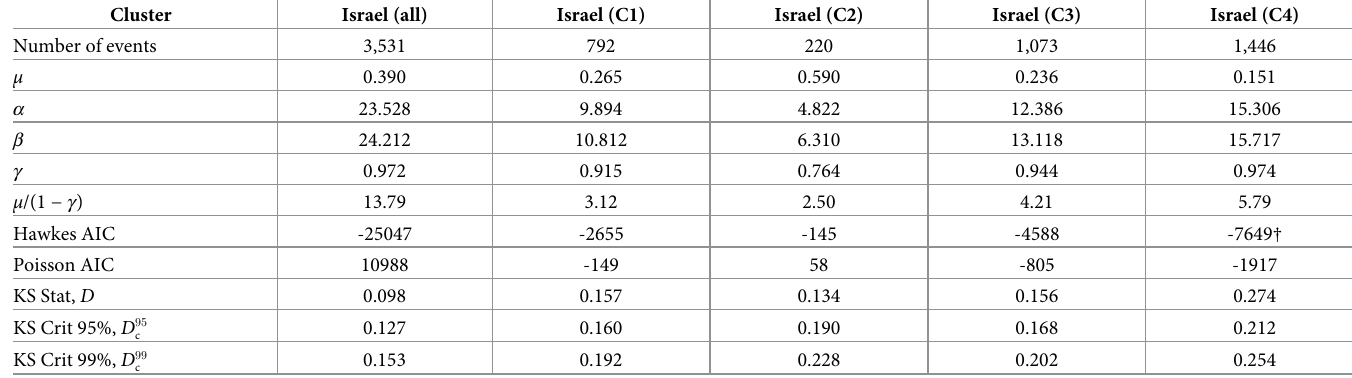
Table 3. Statistical outcomes of the Hawkes process applied to data from Israel. The Hawkes process outperforms the baseline Poisson process both nationwide and in each cluster, since the Hawkes AIC is always less than the Poisson AIC. The Hawkes process passes the KS test at the 95% significance level in all cases except for C4, where , indicating that the hypothesis that the data can be fit to a Hawkes process with a decaying exponential should not be accepted. Given the nature of the data, a D > D 99 c more steeply decaying function than the decaying exponential should be used in